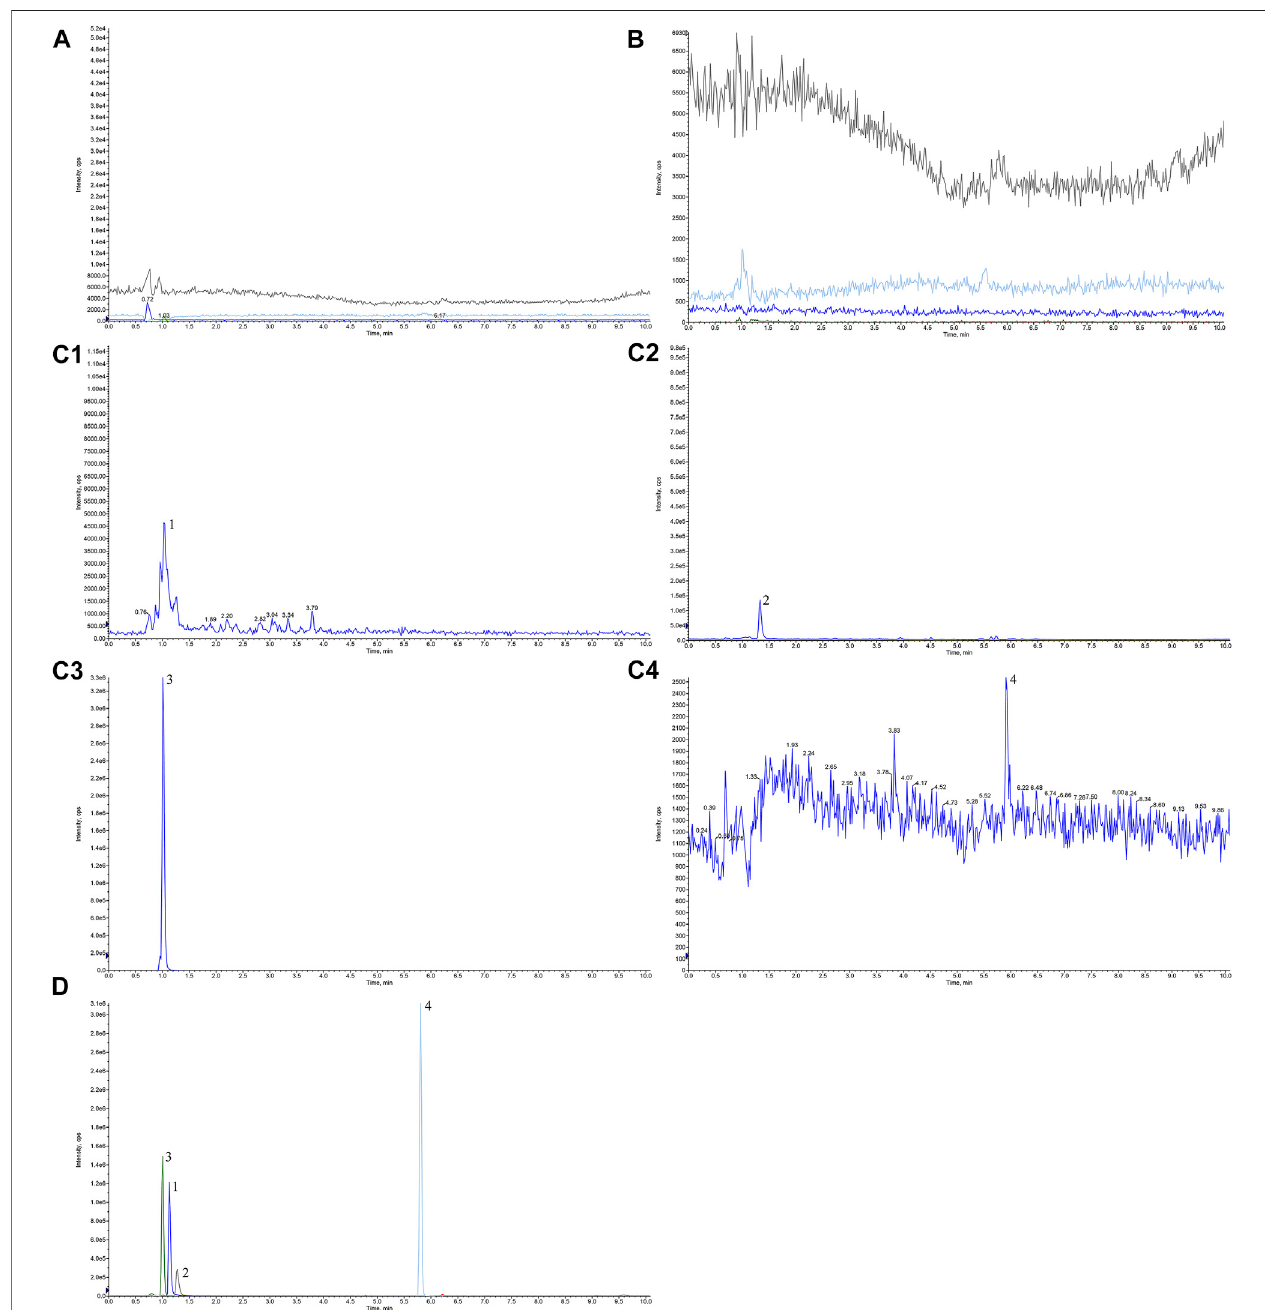
FIGURE 1 | Chromatograms of tetramethylpyrazine, ferulic acid, nodakenin, and isoimperatorin in Chuanxiong Chatiao powder. (A) Blank solvent, (B) negative control solution, (C) test solution, (D) mixed control I solution. (C1) tetramethylpyrazine, (C2) ferulic acid, (C3) nodakenin, and (C4) isoimperatorin. 1, tetramethylpyrazine, 2, ferulic acid, 3, nodakenin, 4, isoimperatorin.